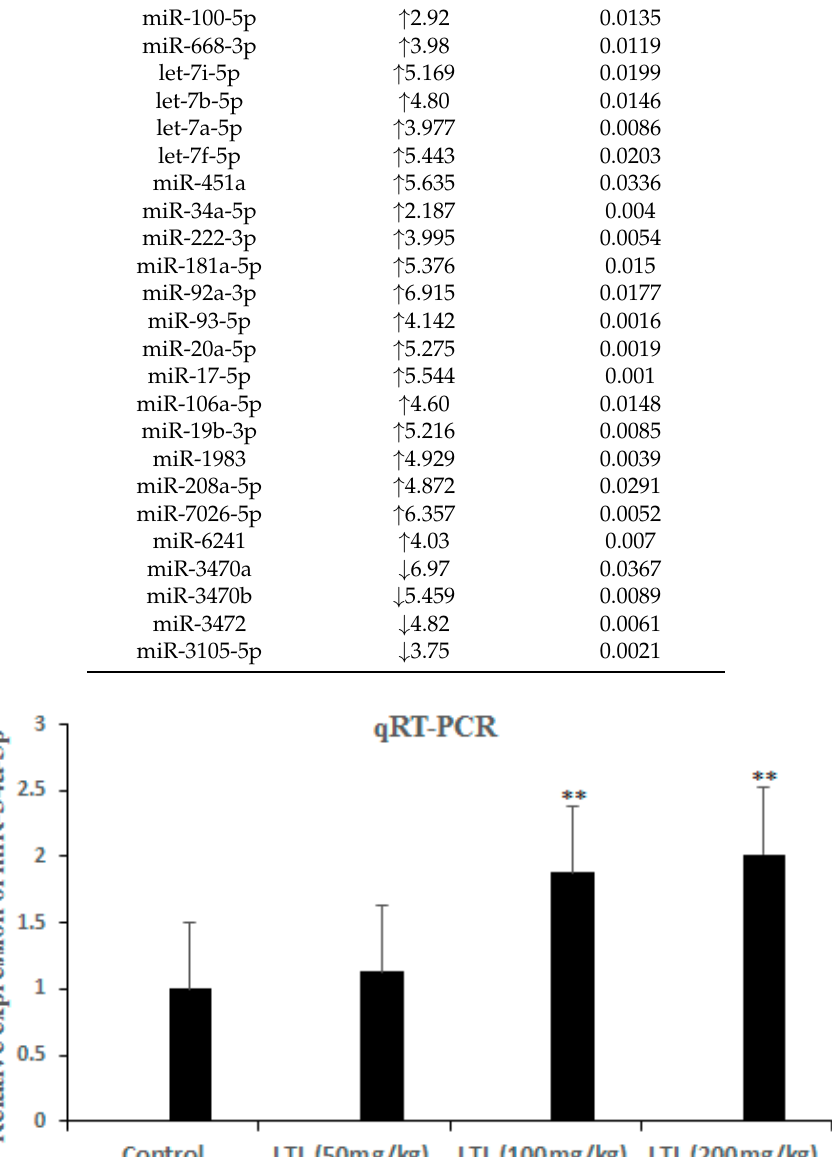
Figure 5. The levels of miR-34a-5p were detected by qRT-PCR in H460 tumor Xenografts. The fold change for miR-34a-5p in LTL-treated groups relative to the vehicle control was analyzed using the 2 −ΔΔ C t method. The results are expressed as means ± SD of three independent experiments. ** p < 0.01, compared with the controls.